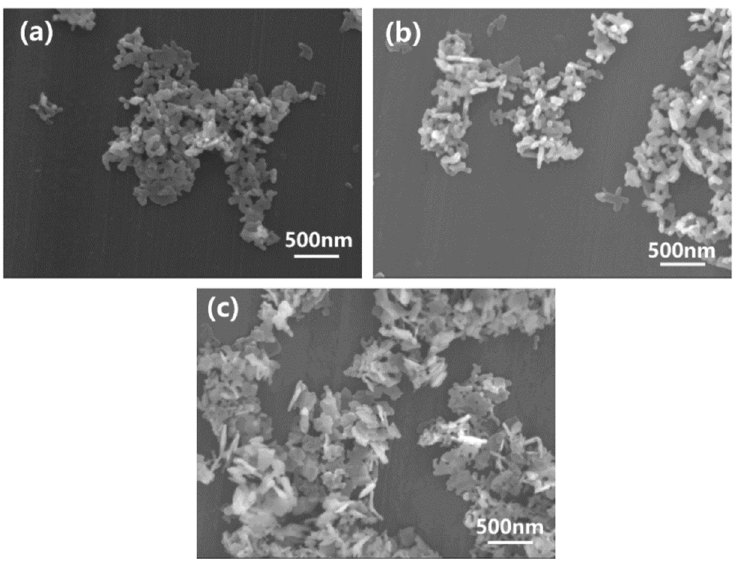
Figure 6. SEM images of MgO-Y 2 O 3 nanopowders synthesized with 5% seeds with different heat treatment temperatures of ( a ) 160 °C, ( b ) 190 °C and ( c ) 220 °C (For comparison, see Figure 4c for 230 °C).